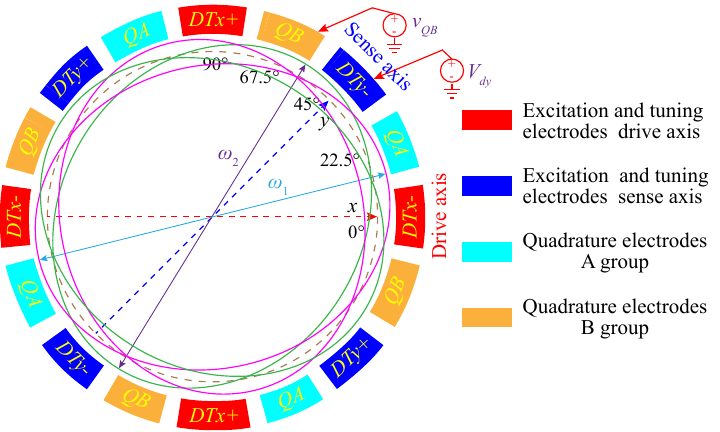
Figure 4. Schematic diagram of the tuning electrodes of the non-ideal